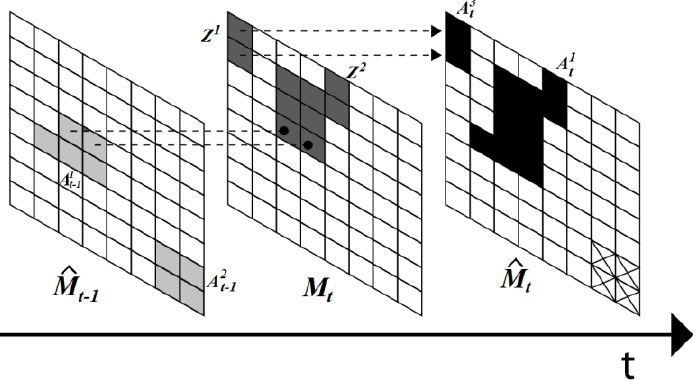
Figure 4. Binary images and obtained applying Equation (19) to each candidate